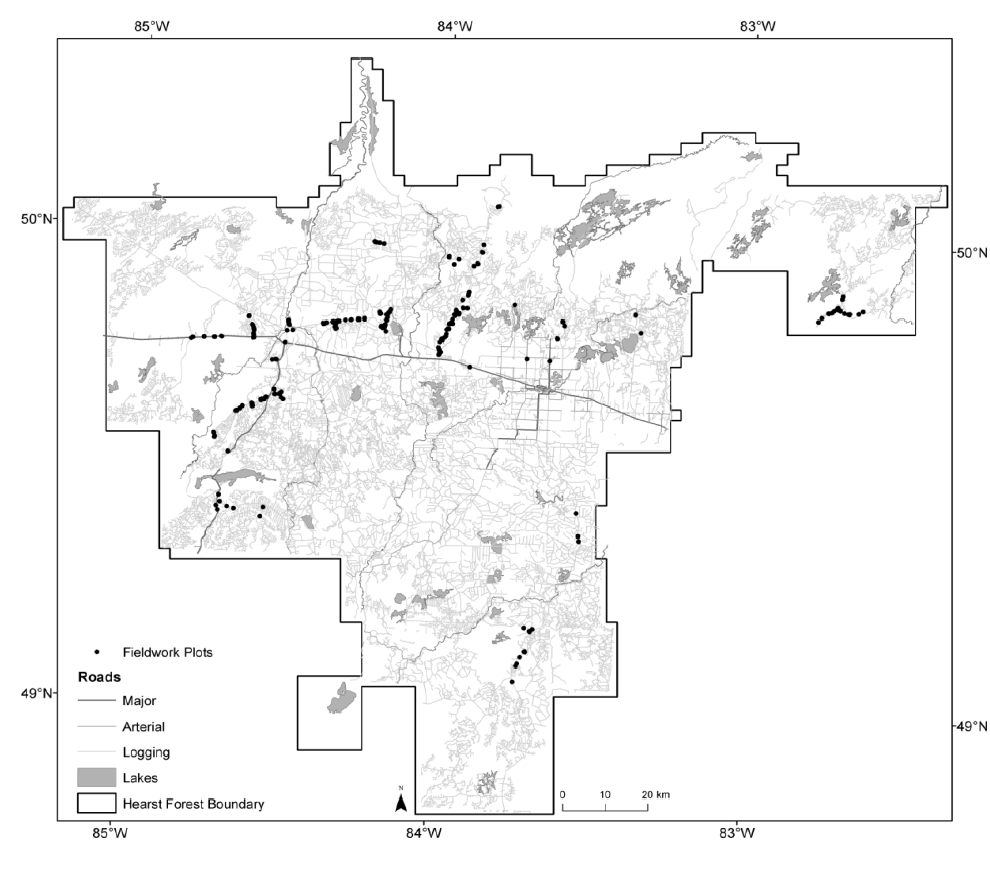
Figure 2. Plot distribution in the Hearst